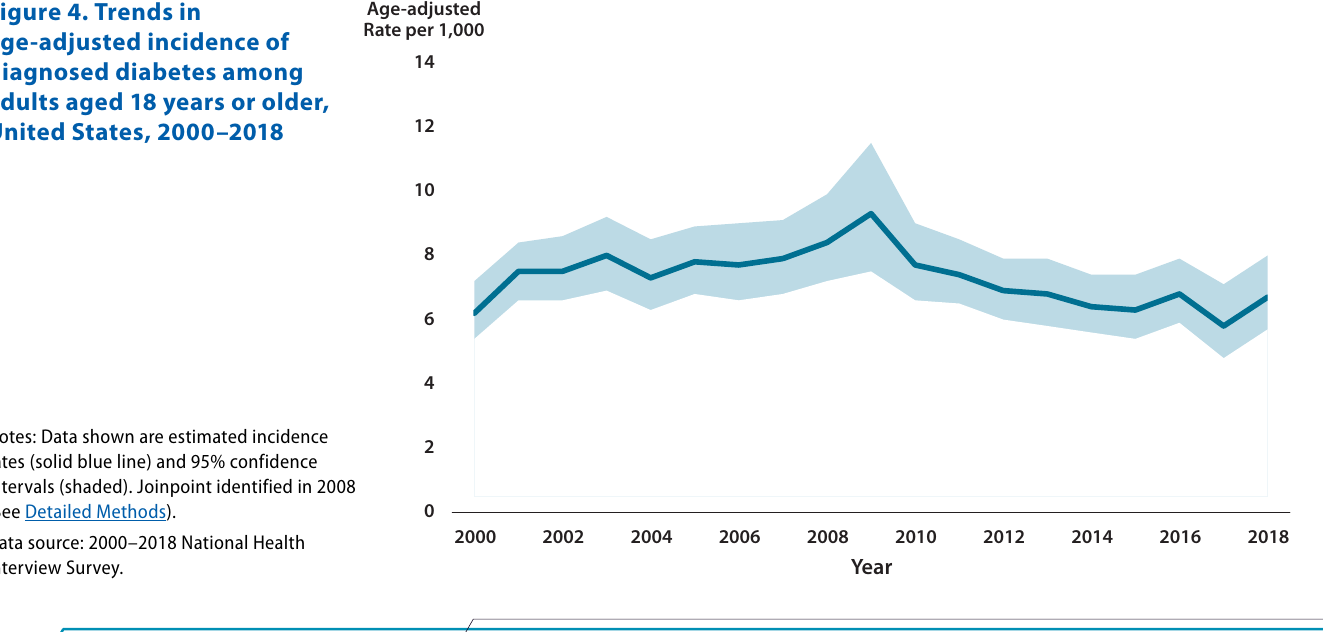
Figure 4. Trends in age-adjusted incidence